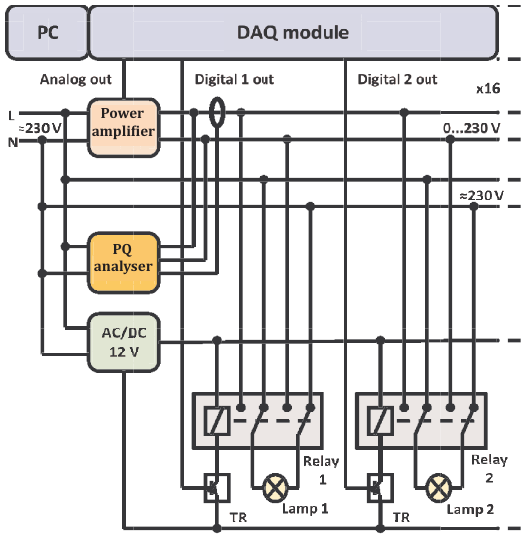
Fig. 7. S Schematic of the measurement setu up.